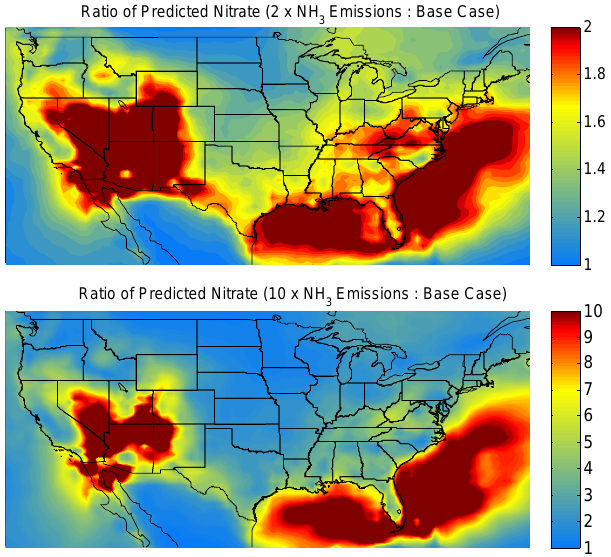
Fig. 10. Ratio of predicted 2009 annual nitrate concentrations in ammonia sensitivity simulations to base case predicted annual ni- trate concentrations.